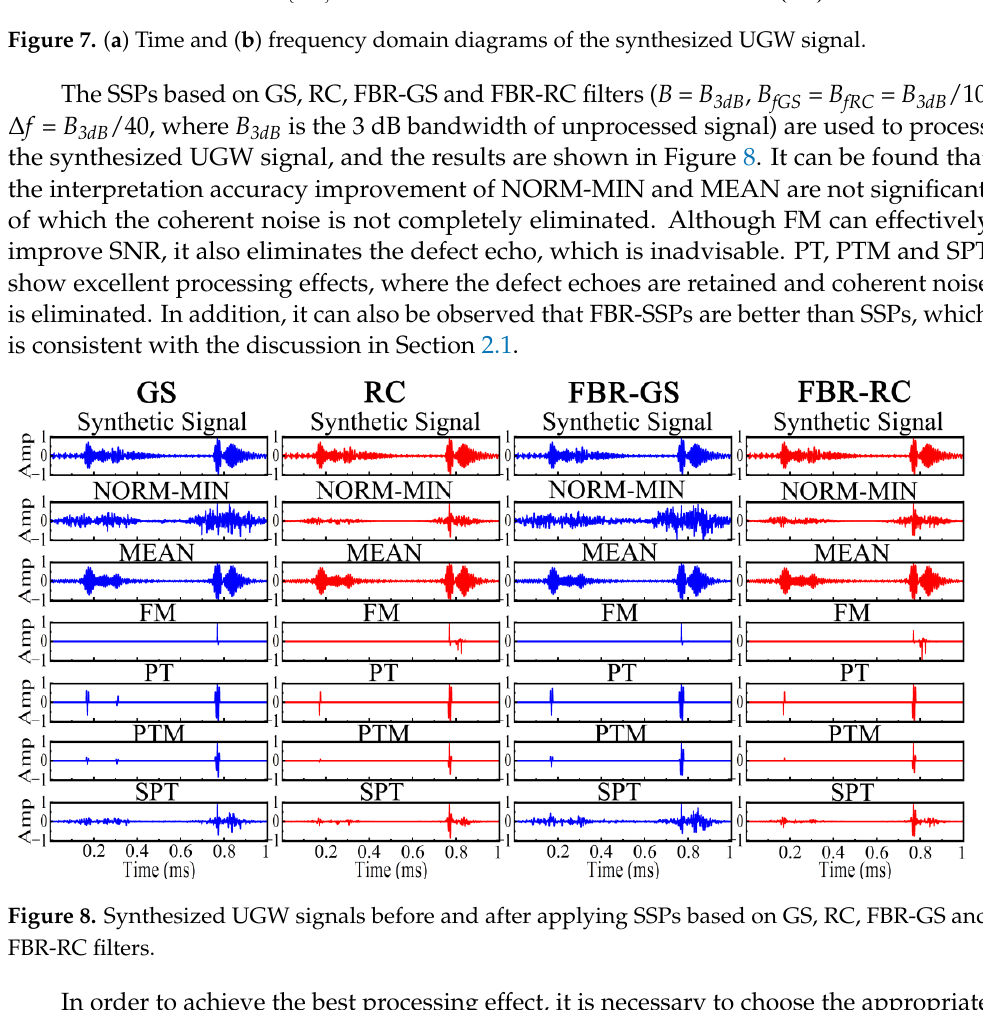
Figure 7. ( a ) Time and ( b ) frequency domain diagrams of the synthesized UGW signal.